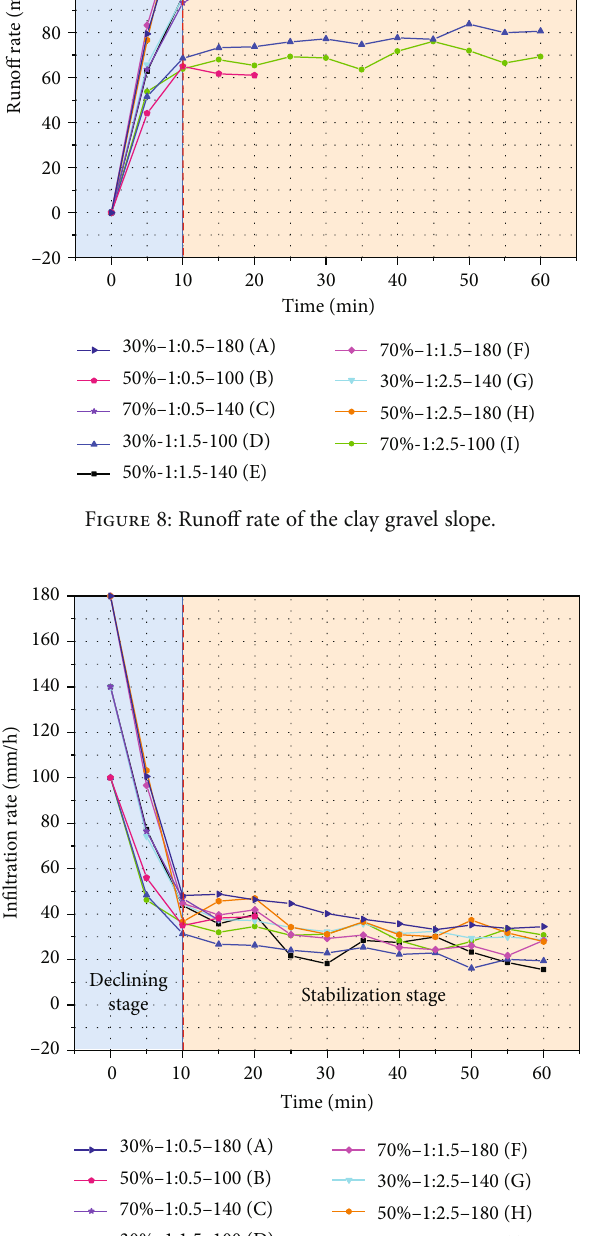
Figure 9: In fi ltration rate of the clay gravel layer slope.